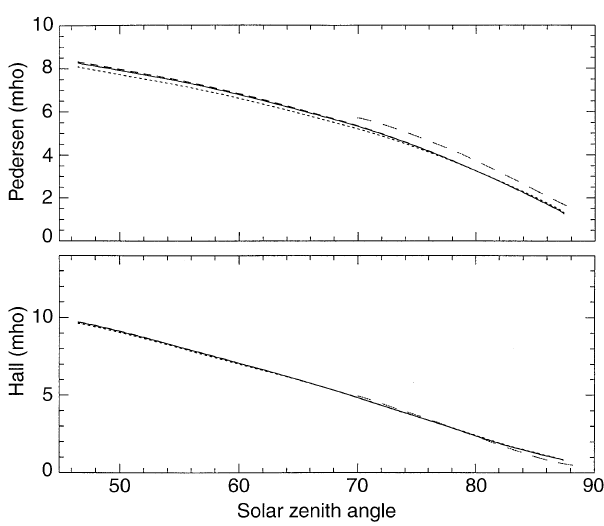
Fig. 5. The full line is the TRANSCAR computation with usual parameters. The thin - dashed line is the same computation with Ap " 20. The dotted line represents the computation for Ap " 3. Finally, the large - dashed line is the computation for day 80